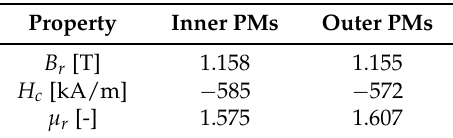
Table 6. PM properties of the uncoupled model, adjusted according to their operating temperature with electrical loading of 3 A/mm 2